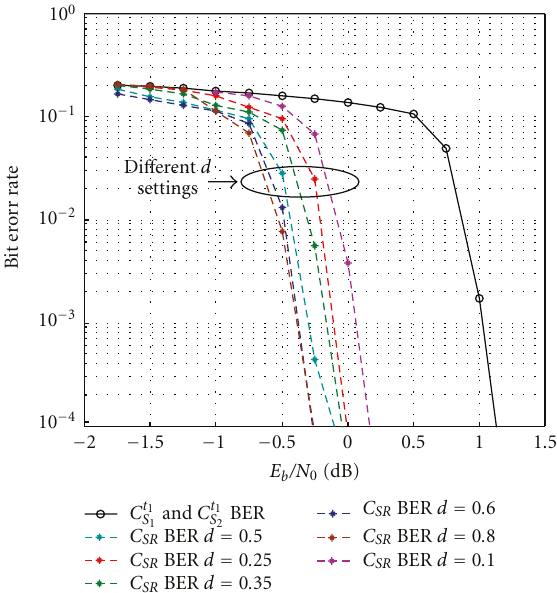
Figure 15: The BER performance under the Rayleigh Fast Fading channel with di ff erent settings of d , the distance between Source and